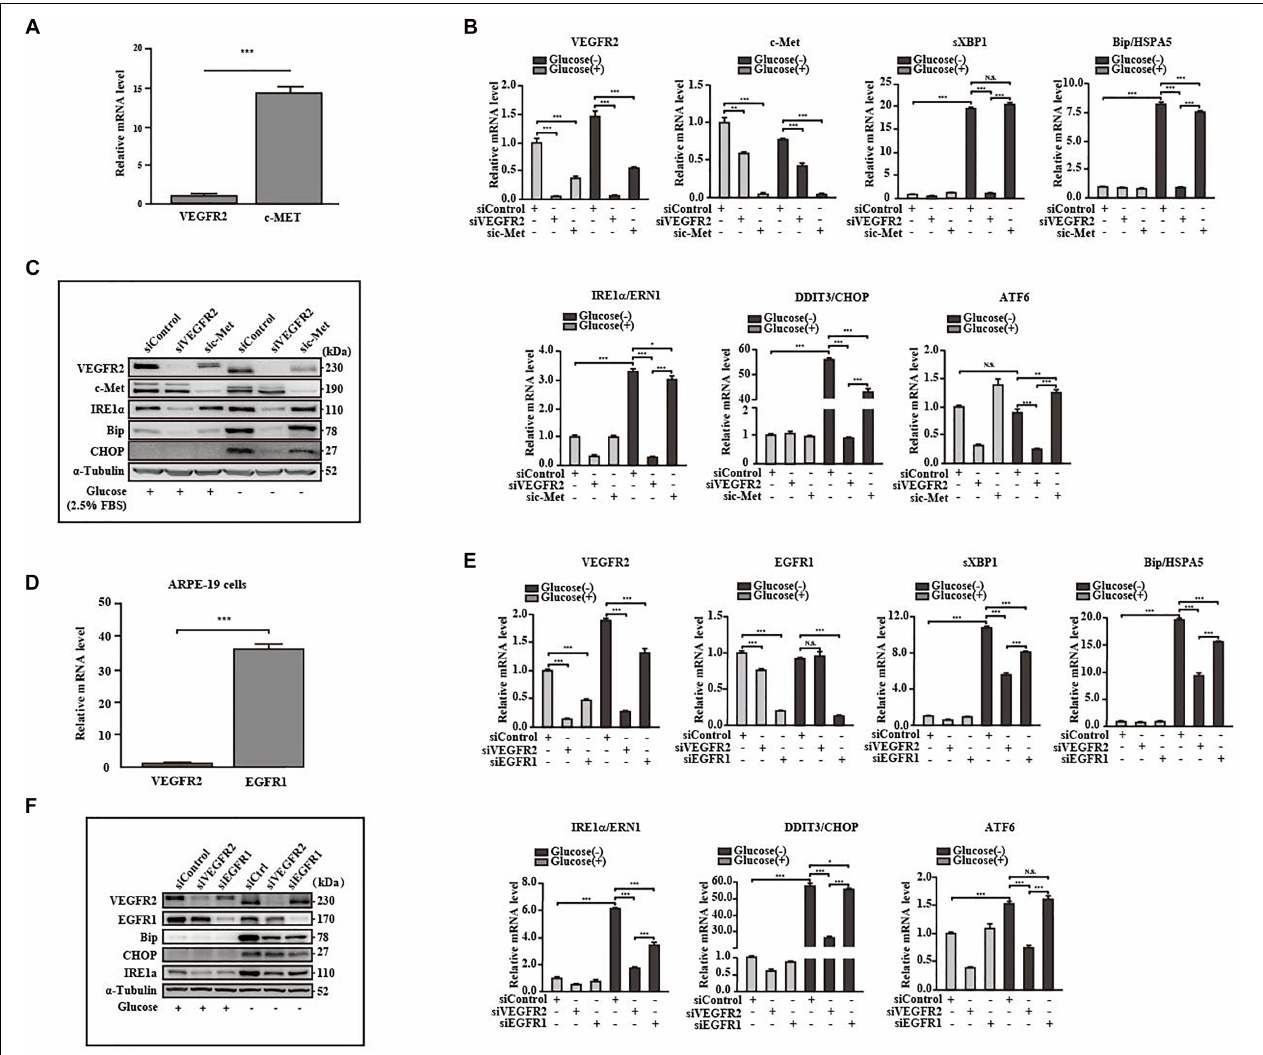
FIGURE 5 | VEGFR2 was a potent ER stress inducer under glucose deprivation compared to other receptors. (A) Comparison of expression between VEGFR2 and c-Met at the RNA level. (B,C) Comparison of the ER stresses triggered by glucose deprivation between VEGFR2 and c-Met knockdown indicated by the markers at the RNA and protein levels, respectively. (D) Comparison of expression between VEGFR2 and EGFR1 at the RNA level. (E,F) Comparison of the ER stresses triggered by glucose deprivation between VEGFR2 and EGFR1 knockdown indicated by the markers at the RNA and protein levels, respectively. Data in (A,B,D,E) are the means of three independent experiments ( n = 3). All error bars indicate S.D. * P < 0.05, ** P < 0.01, *** P <